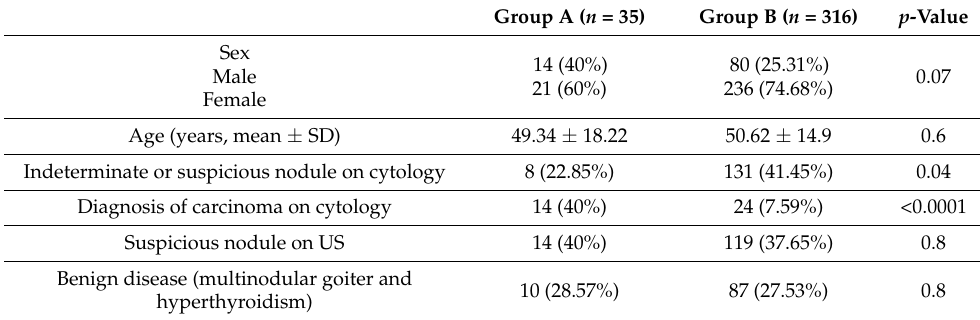
Table 1. Demographic and preoperative data.